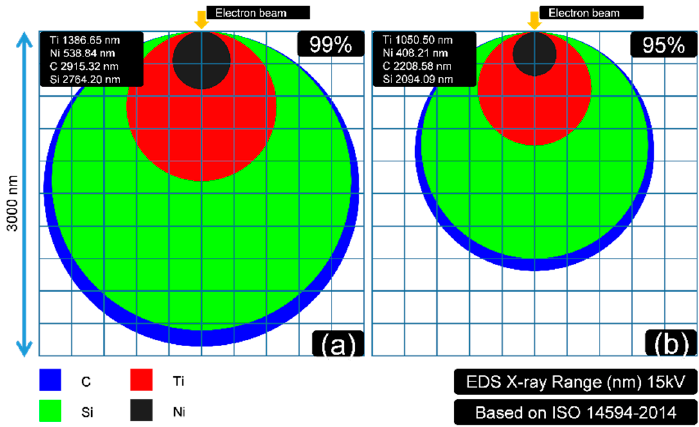
Figure 6. The illustration (X-ray zone was regarded approximately as a sphere) of the detected X-ray depth for each element (C, Si, Ti, and Ni): ( a ) depth of 99% of the X-ray signal detected; ( b ) depth of 95% of the X-ray signal detected.